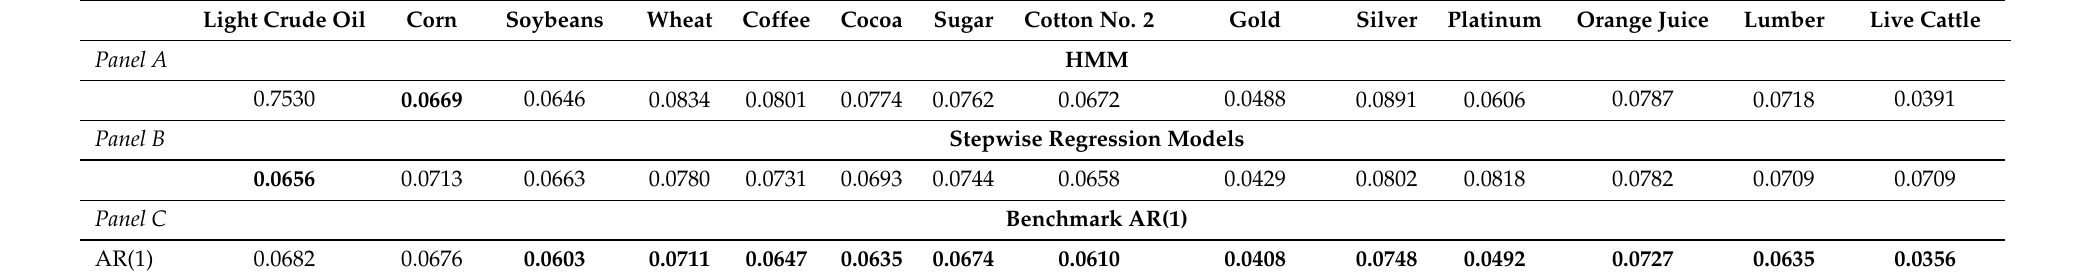
Table 6. Mean absolute error forecast performances—Markov switching vs. stepwise regression models, equally weighted. The table compares the MFE statistics implied by an equally-weighted average of the forecasts obtained from the three HMM and the 24 stepwise (forward and backward) predictive regression models recursively implemented in our analysis. In particular, the table obtains the forecasts by weighting (over the entire OOS period, January 2004–May 2018) the regime-specific stepwise regression forecasts by the predicted regime probabilities obtained from a two-state HMM for the VIX index. In the different panels we have boldfaced the forecasting model that yields the minimum